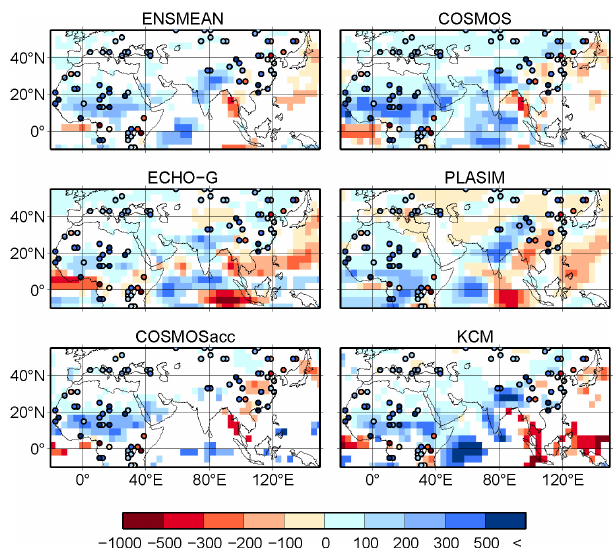
Figure 5. Simulated mean annual precipitation difference (shaded, mmyear − 1 ) between mid-Holocene (6k) and pre-industrial climate (0k). Only significant values are shown, i.e. significant at the 95% level (student’s t test) for the non-accelerated experiments (ECHO- G, COSMOS, PLASIM) and significant at the 90% level for the ac- celerated experiments (COSMOSacc, KCM). The ensemble mean (ENSMEAN) is defined as significant if all simulations agree in the sign of the precipitation change in the individual grid-boxes. The re- constructions of Bartlein et al. (2010) are additionally shown (dots, same legend as the simulated data). to 650 mm year − 1 in KCM). COSMOSacc is the only model revealing no significant